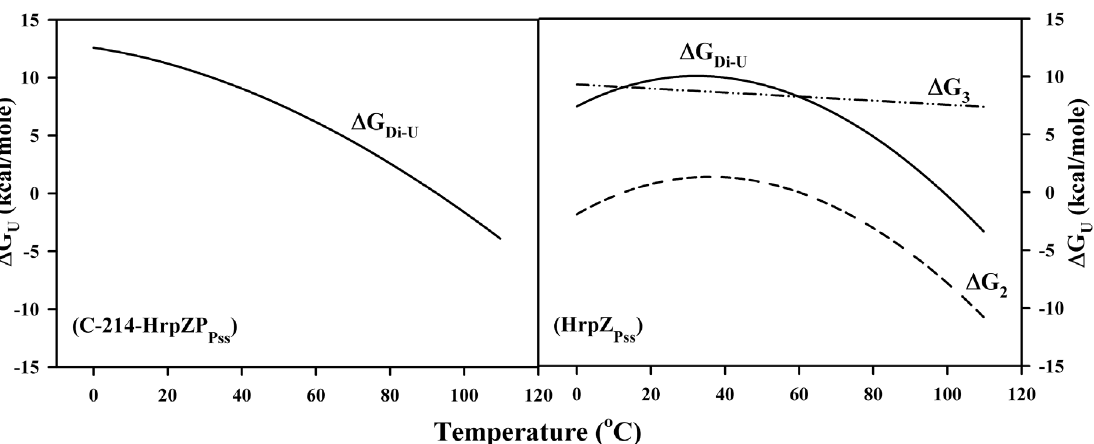
Fig. 6. Conformational stability curves of C-214HrpZ Pss and HrpZ Pss . Solid lines correspond to dimer - unfolded state transition ( D G Di-U ). Values of D G 2 and D G 3 for HrpZ Pss corresponding to transition 2 and 3 were calculated using equations 1 and 2 (see text for more